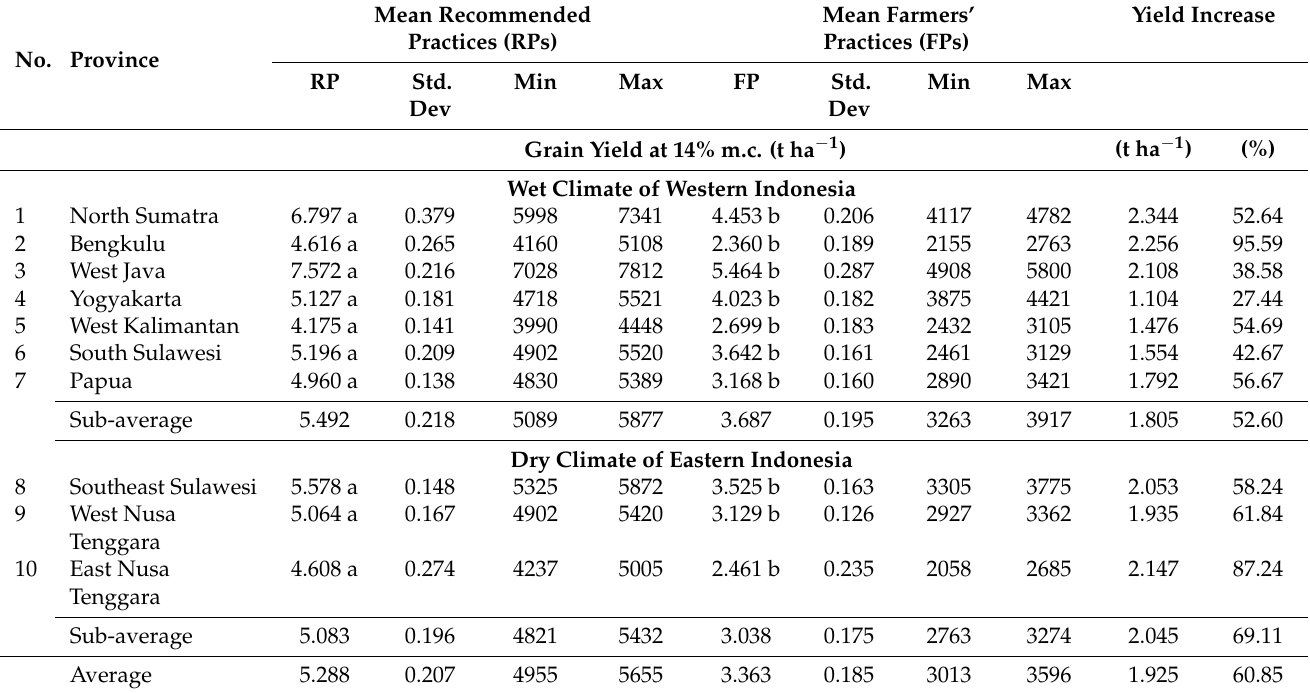
Table 5. Disaggregated rice grain yield and yield increase compared between RPs and FPs in rainfed lowlands sorted by the wet climate of western Indonesia and the dry climate of eastern Indonesia, DS